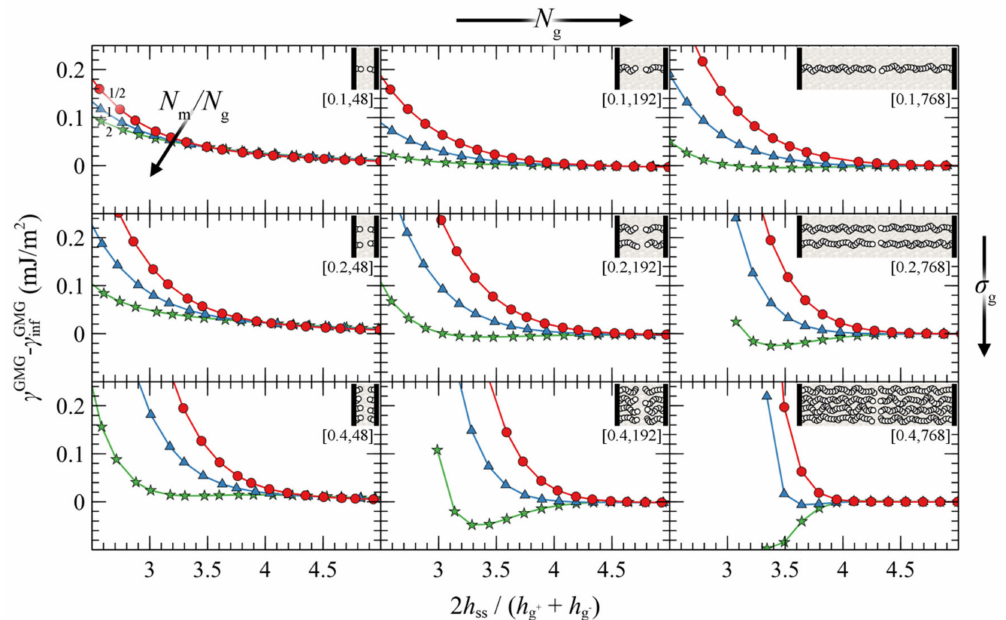
Figure 7. Potential of mean force against the reduced surface-surface distance in a symmetric system of approaching grafted silica surfaces in a melt from the SL EoS. Colors correspond to evaluations for N m / N g = 1/2 (red), 1 (blue) and 2 (green), whereas the labels in brackets denote σ g (nm − 2 ) and N g . Lines are guides to the eye.